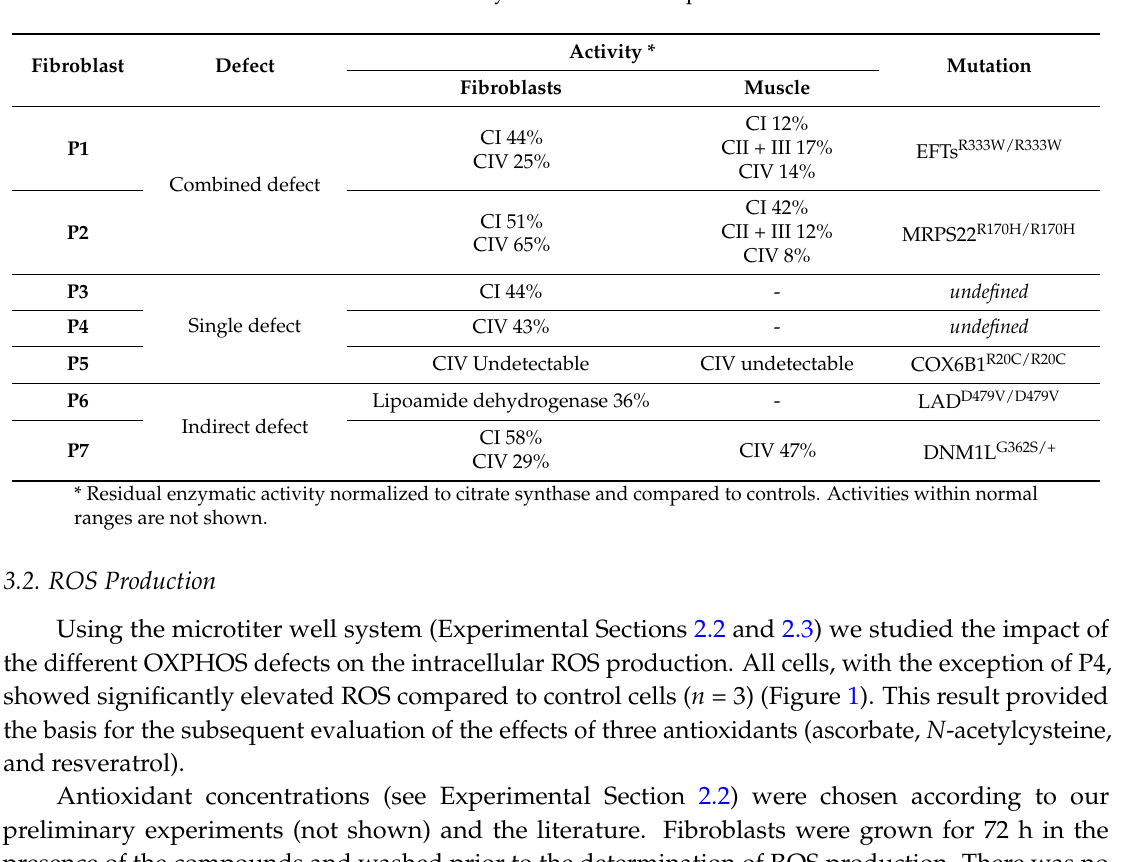
Table 1. Mitochondrial enzymatic activities in patients’